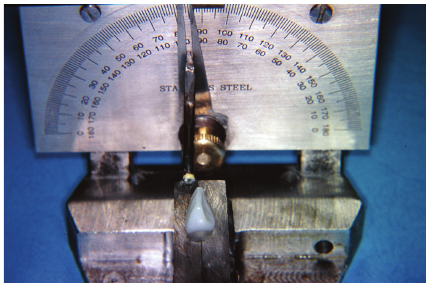
Figure 1: Metallic block with protractor used for the experiment.